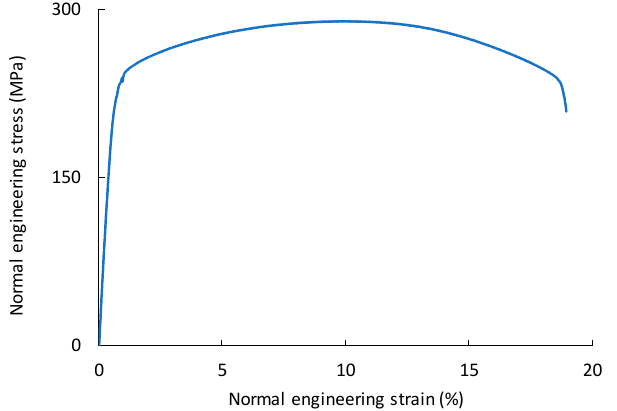
Figure 2. Engineering stress–strain curve for ZK60-T5 along the extrusion direction.